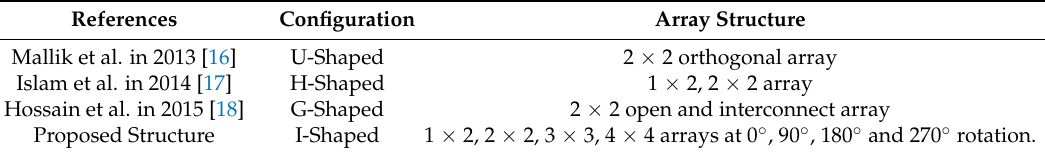
Table 9. Array structural comparison with the reported